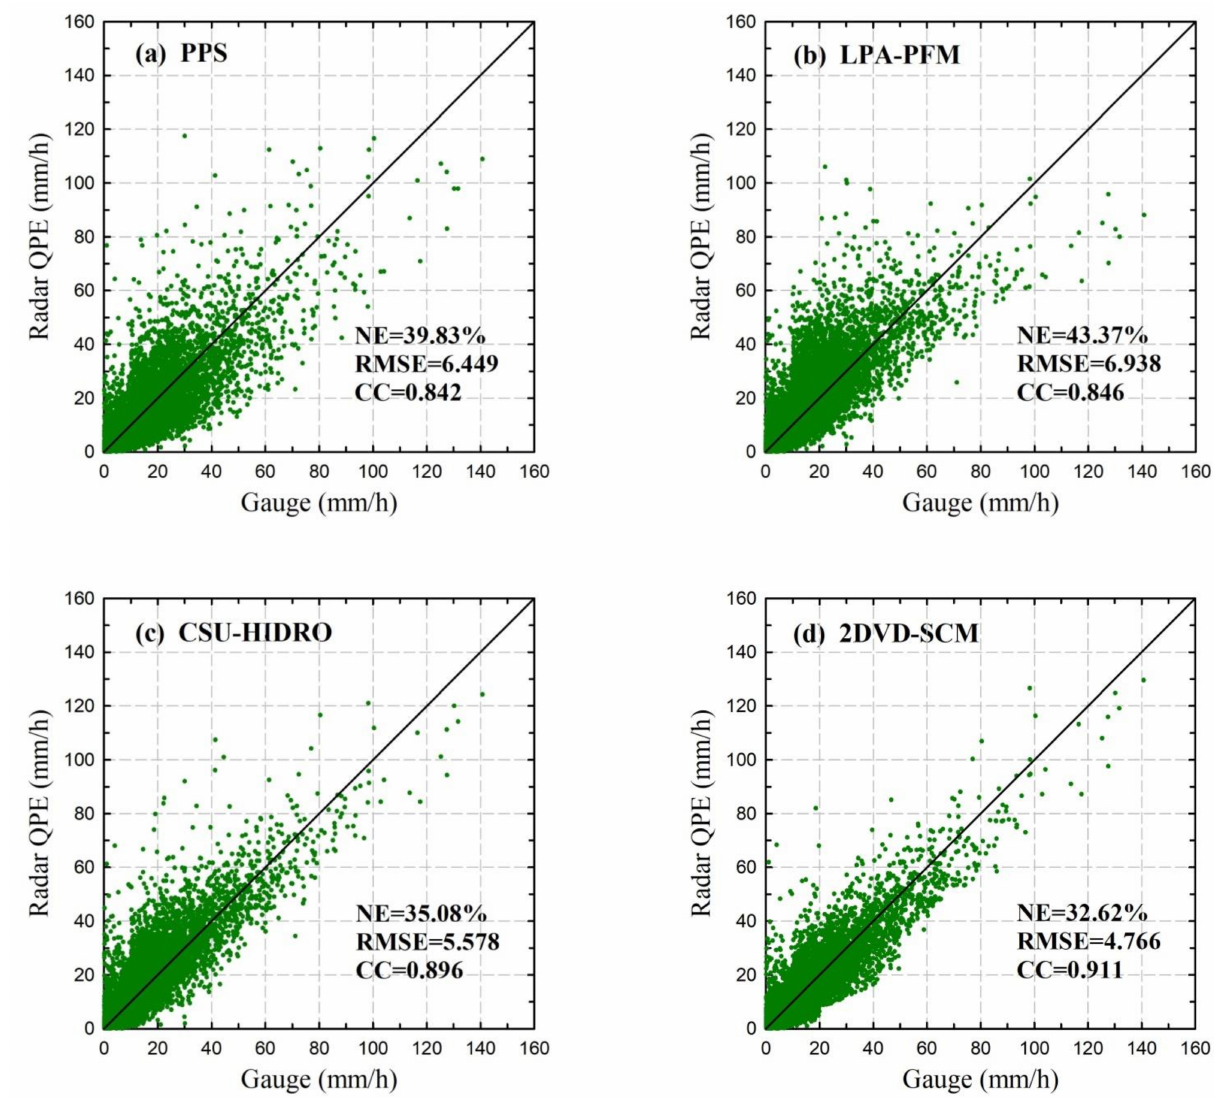
Figure 9. Scatterplots show estimated hourly rainfall from ( a ) PPS, ( b ) LPA-PFM, ( c ) CSU-HIDRO, and ( d ) 2DVD-SCM compared with rain gauge observations for all eight rainfall